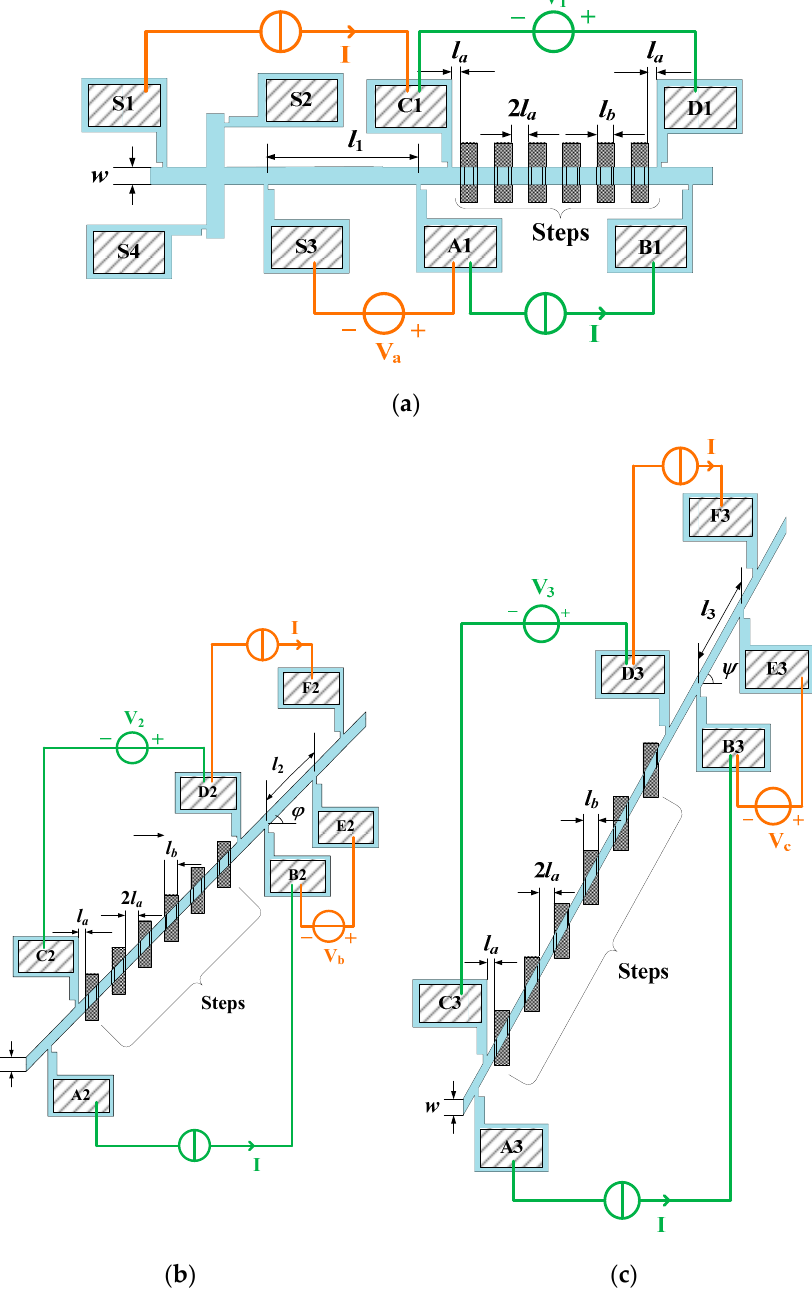
Figure 3. Schematic illustration of the test structure for measuring geometrical parameters of surface micromachined thin films: ( a ) Unit 1; ( b ) Unit 2; ( c ) Unit 3.